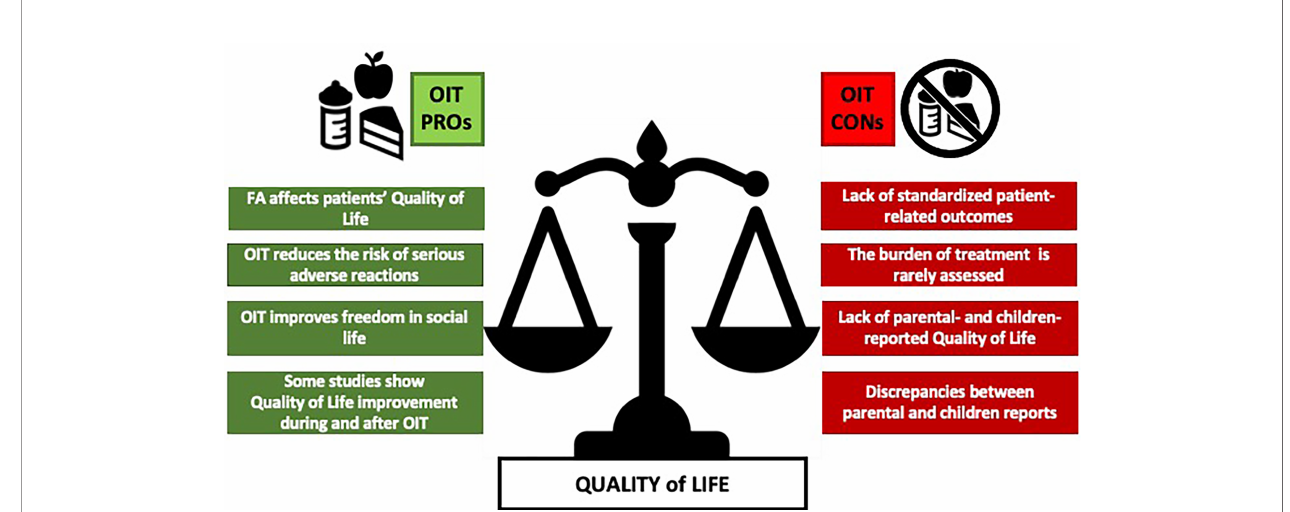
FIGURE 3 | A comparison between the main PROs and CONs arguments on OIT quality of life. FA, food